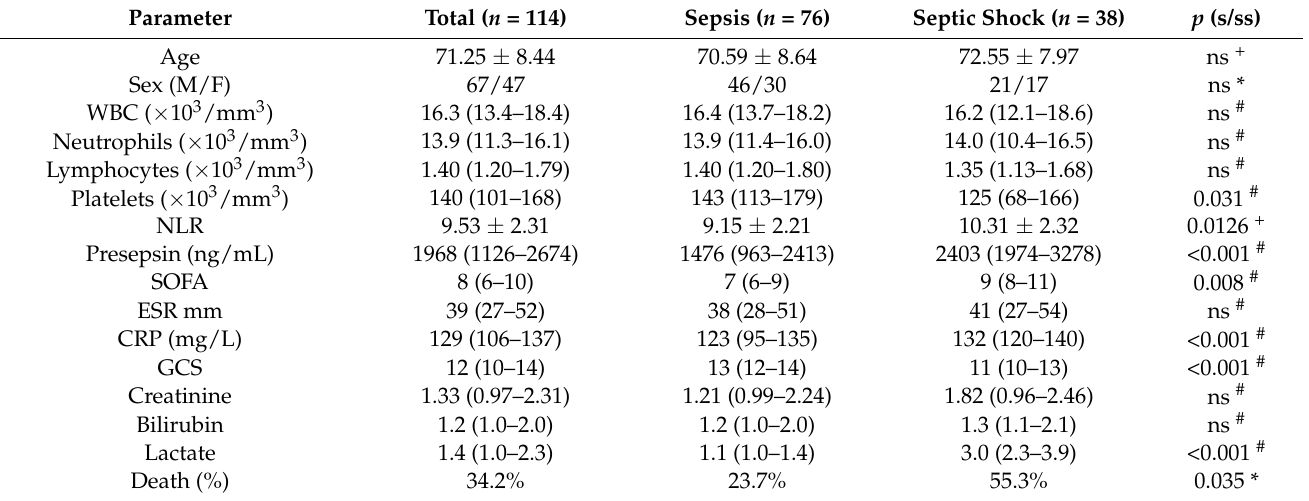
Table 1. Study patients ′ characteristics (most significant parameters selected). Data presented as mean ± SD or median and quartile range (25%–75%). (ns = not-significant, n/a = not applicable, s = sepsis, ss = septic shock, * = Fisher ′ s exact test, # = Mann-Whitney U test, + = Student t-test, WBC= white blood cells, NLR = Neutrophil to Lymphocyte Ratio, SOFA = Sequential Organ Failure Assessment, ESR = Erythrocyte Sedimentation Rate, CRP = C Reactive Protein, GCS = Glasgow Coma Scale).